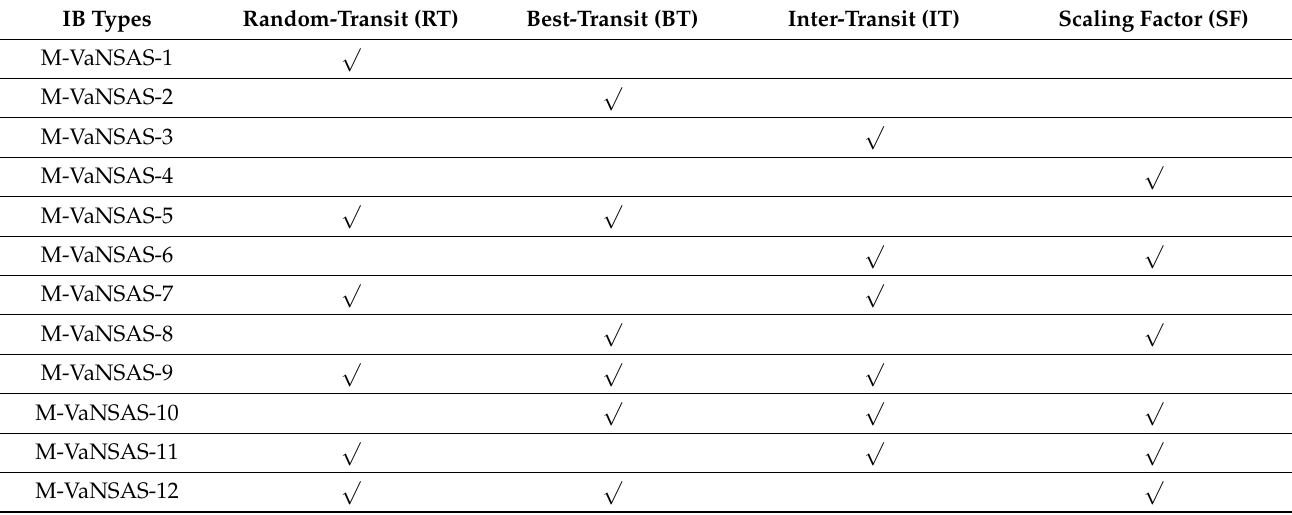
Table 14. Details of the subalgorithm of M-VaNSAS.